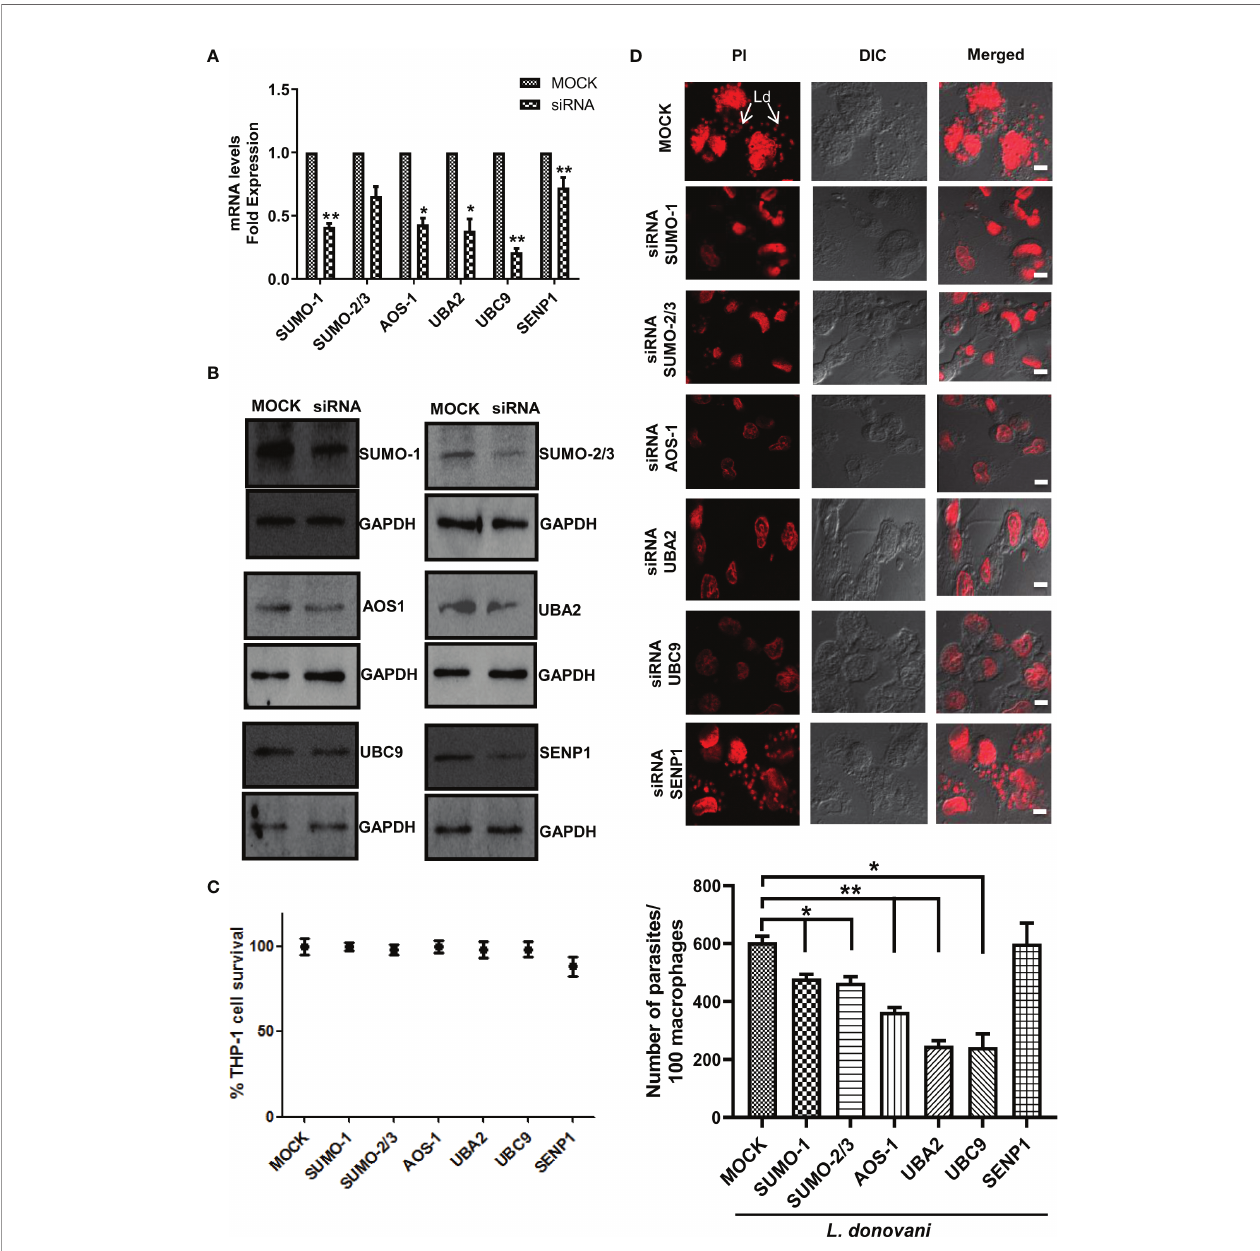
FIGURE 2 | Host SUMOylation pathway favors the growth of Leishmania donovani in macrophages. PMA-differentiated THP-1 macrophages were transiently transfected with siRNA against speci fi c genes for 36 h MOCK here represents the transfection with a control siRNA. (A) Total RNA was enriched using TRIzol (Qiagen). mRNA levels of transfected macrophages with target genes compared to MOCK were quanti fi ed by qRT-PCR. * p = 0.02, 0.03, and 0.04 for MOCK vs. SUMO-1 , AOS-1 , and UBA2 , respectively; ** p = 0.0012 and 0.01 for MOCK vs. UBC9 and SENP1 , respectively. (B) Cell lysates of transfected macrophages were used to check the transfection ef fi ciency by Western blotting. GAPDH was used as the loading control for each set separately. (C) Effect of transfection on cell viability measured by MTT assay. THP-1 macrophages were transfected with speci fi c siRNAs and control siRNA (MOCK) for 36 (h) No signi fi cant changes in cell viability were observed upon the transfection of siRNAs against target genes compared to MOCK. (D) PMA-differentiated macrophages were transfected with speci fi c siRNAs followed by L. donovani infection for 6 (h) Macrophages were stained with propidium iodide after 24 h post-infection, and parasitic load in the infected macrophages was calculated under confocal microscopy. Scale bar, 5 µm. Data from one of three experiments are shown. Parasite load was counted in 100 macrophages. Statistical signi fi cance was quanti fi ed using the unpaired t-test with Welch ’ s correction, * p = 0.0286, 0.0222, and 0.0266 for MOCK vs. SUMO-1 , SUMO-2/3 , and UBC9 , respectively; ** p = 0.0087 and 0.0034 for MOCK vs. AOS-1 and UBA2 , respectively. PMA, phorbol 12-myristate